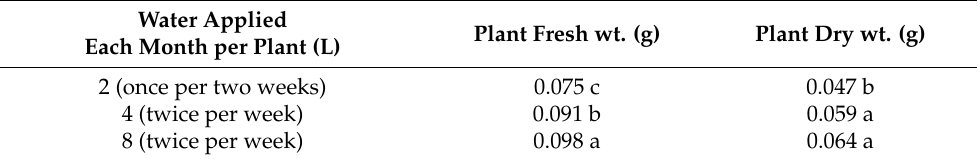
Table 4. Influence of irrigation regime on basil fresh and dry weights in an extensive green roof environment.